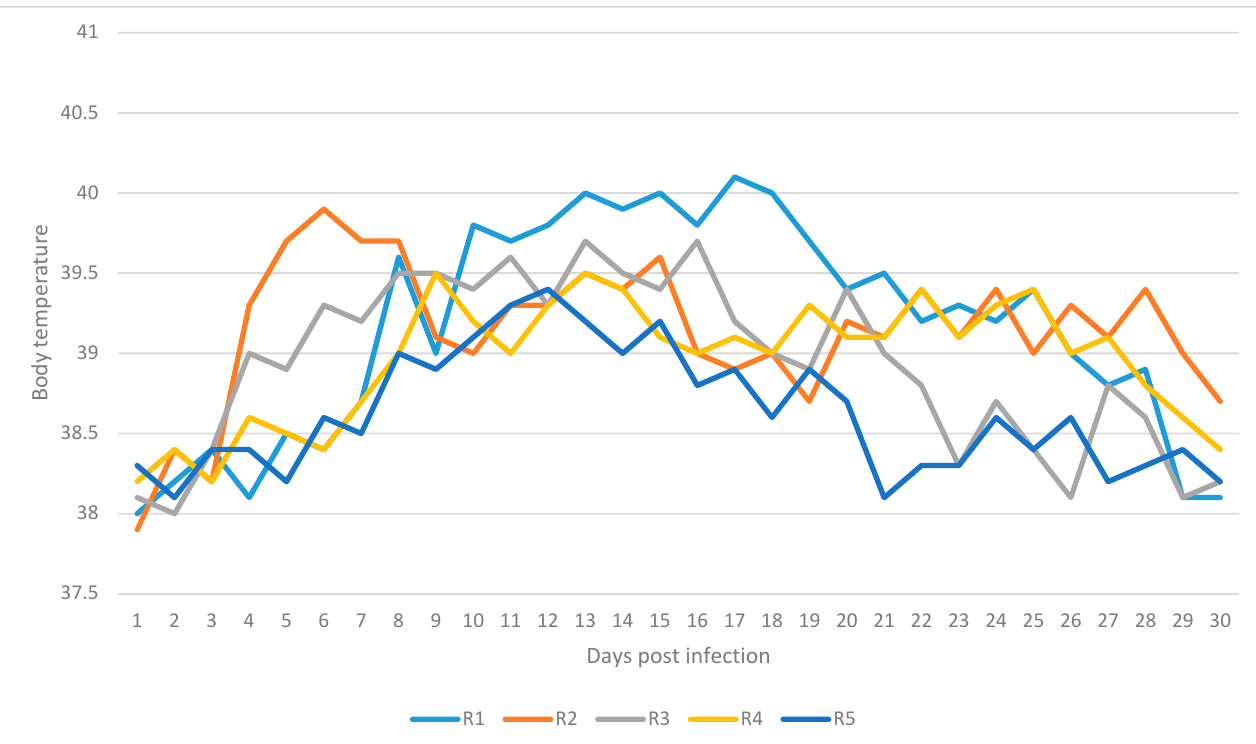
Figure 1. Daily temperatures for recipient animals: R1, R2, R3, R4 and R5. Table 2. Clinical manifestations of LSD for recipient animals infected through transmission of LSDV by Stomoxys spp.